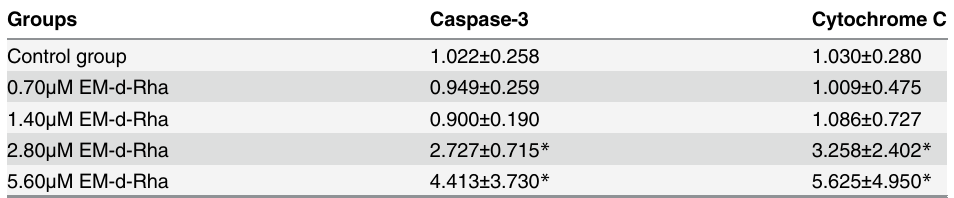
Table 8. Effects of EM-d-Rha regulating Cyto C and Caspase-3 gene expression of HepG2 cells. Groups